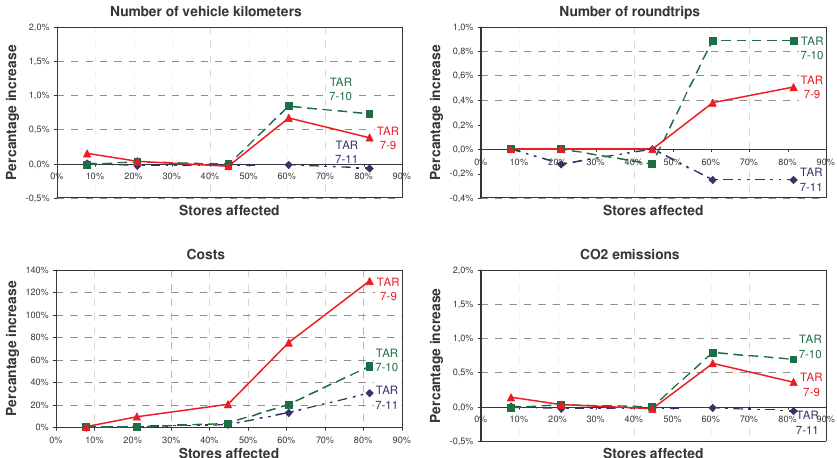
Figure 6. Values for FR1 and the time access restriction policy measure